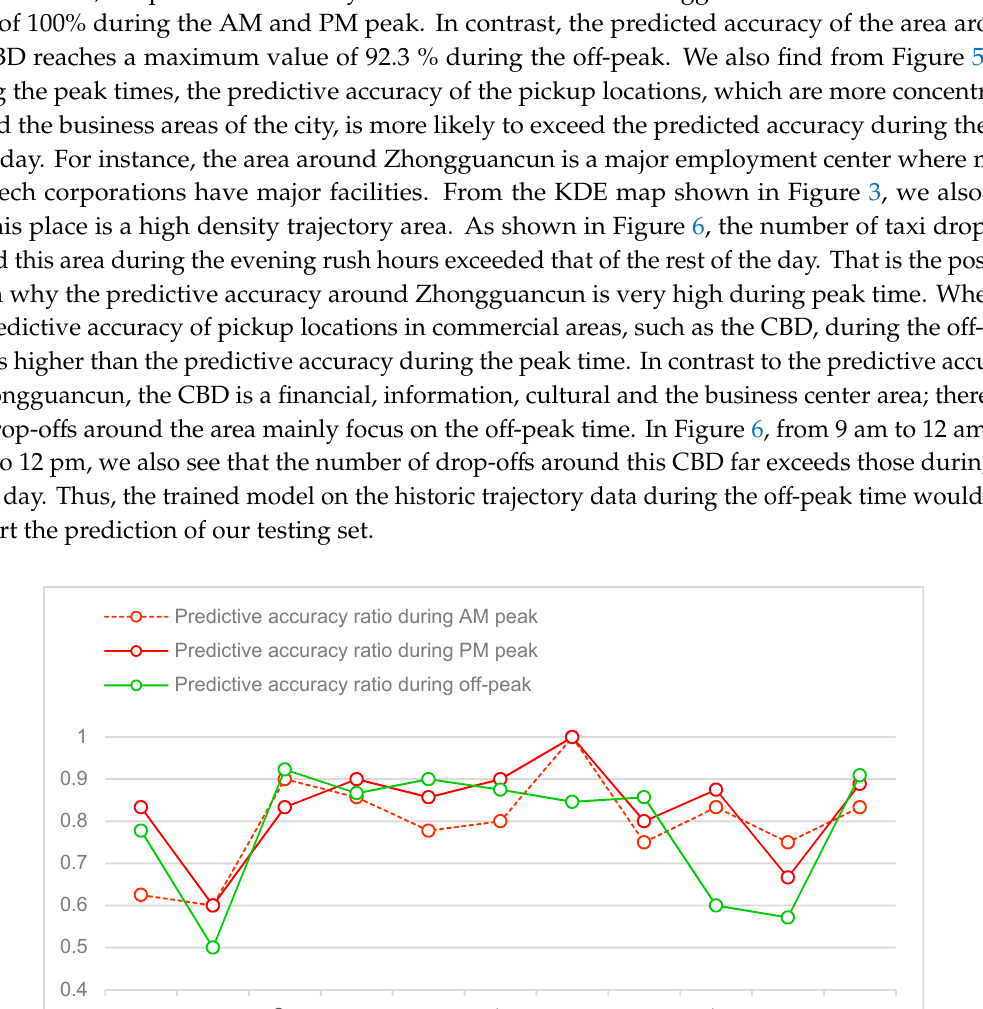
Figure 6. The number of drop-offs during different time intervals within one day. 387